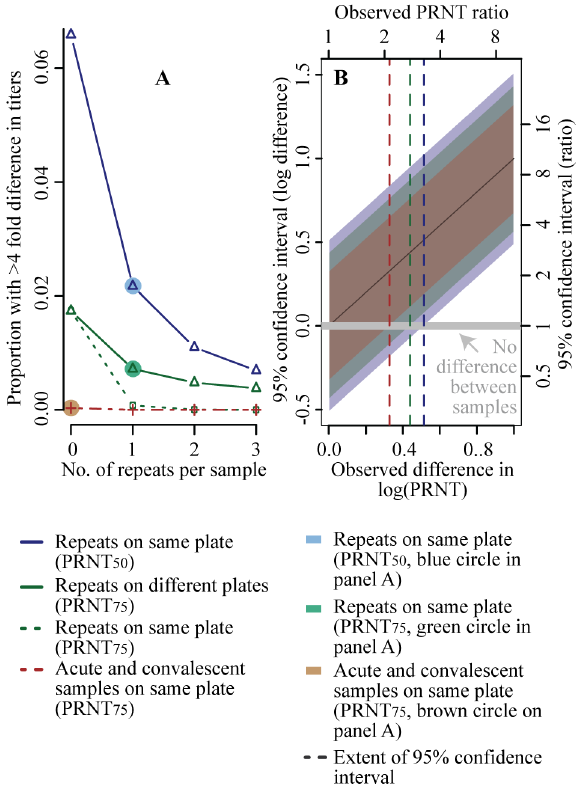
Figure 5. ( A ) Probability of detecting a greater than four-fold difference in titers between paired sera where no true difference exists. All titers calculated through cloglog regres- sion. ( B ) Example confidence intervals for the log difference between titers calculated from paired sera (and the equivalent intervals for the ratio) under different scenarios of PRNT evaluation points and where repeat dilutions are performed.